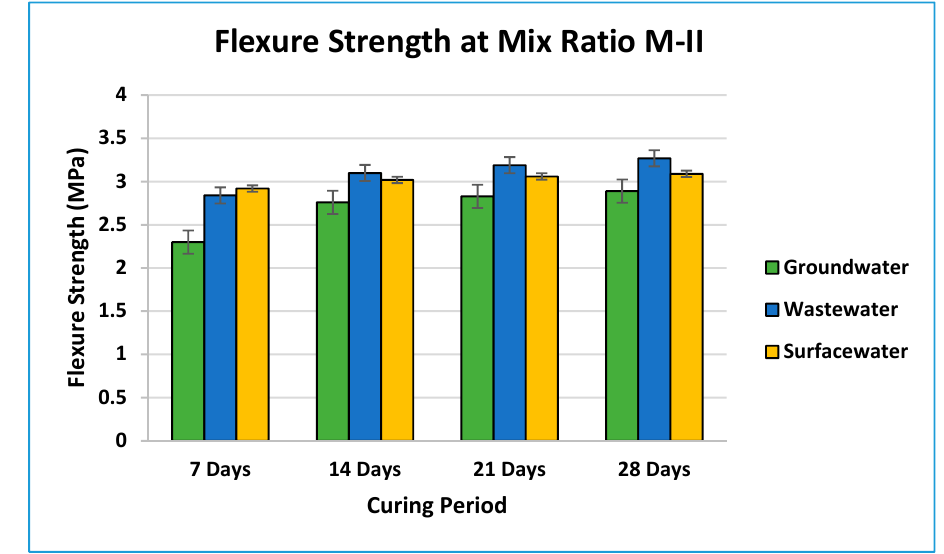
Figure 9. Flexural strength of concrete for the ratio M-II (1:1.5:3).